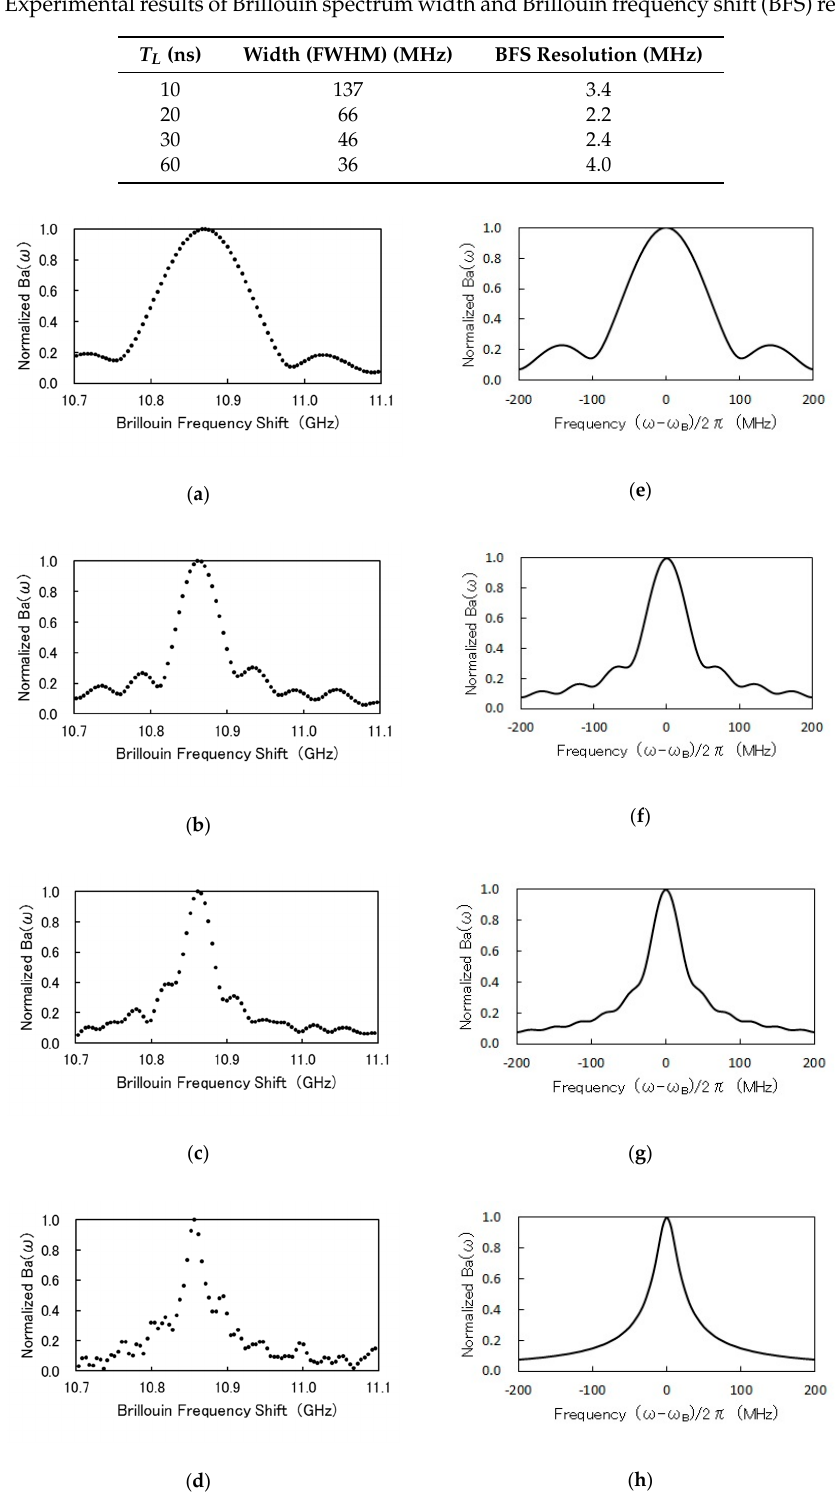
Table 1. Experimental results of Brillouin spectrum width and Brillouin frequency shift (BFS) resolution.